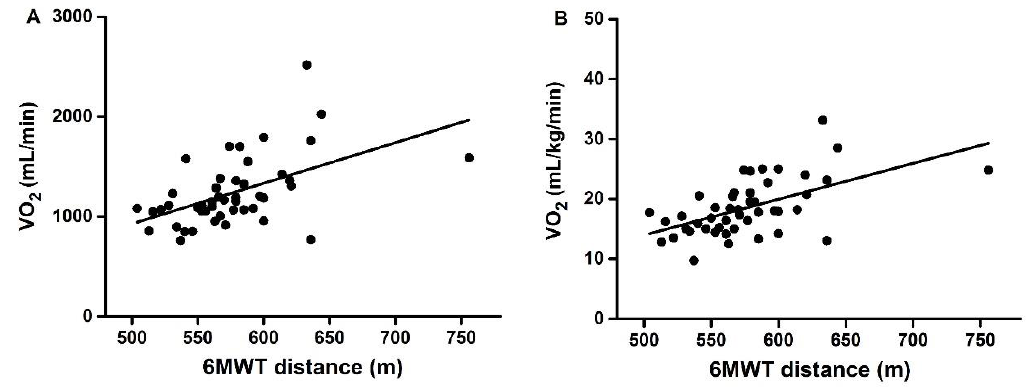
Figure 1. Correlation between 6MWT distance and VO 2 ( A ) or relative VO 2 ( B ) at R = 1. R: respiratory exchange ratio.